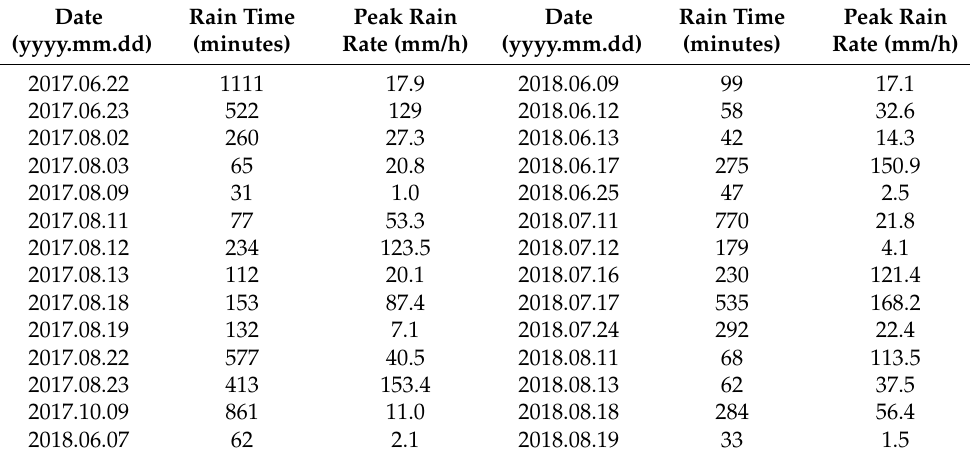
Table 2. Rain Record from June 2017 to August